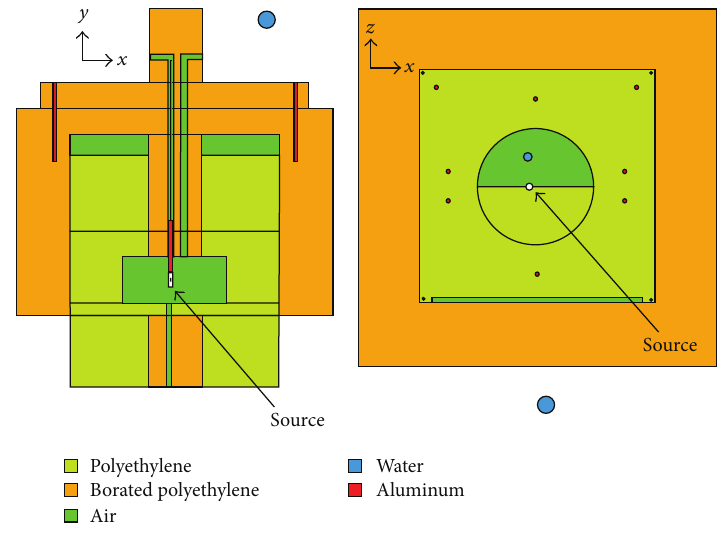
Figure 5: MCNP model of neutron irradiator.